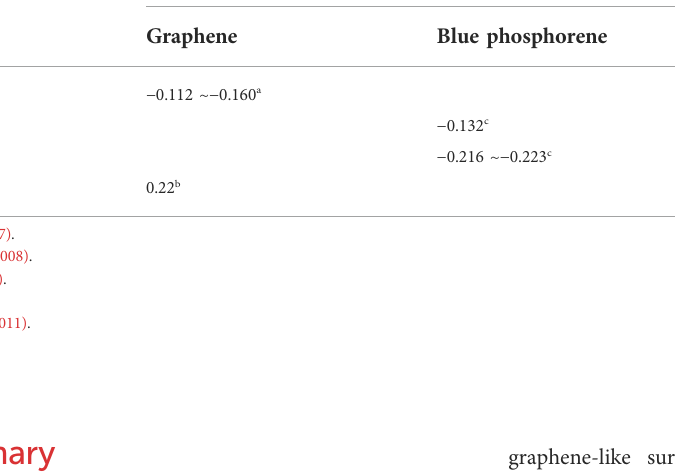
TABLE 4 Based on the DFT theory, theoretical values for the E ads of interstellar molecules on different substrates.